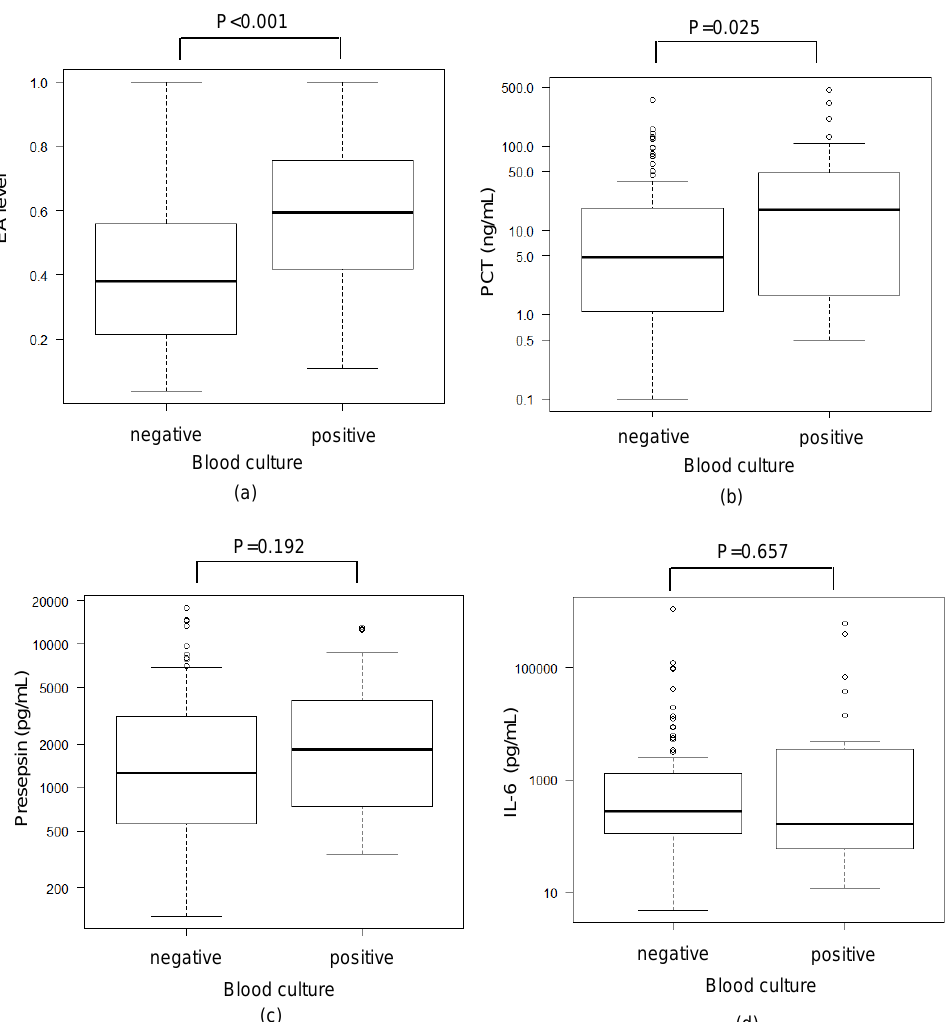
Figure 3. Comparison between the blood culture results and various biomarkers. ( a – d ) Comparisons between the EA level ( a ), PCT level ( b ), presepsin level ( c ), or IL-6 level ( d ) in the blood culture-negative and blood culture-positive groups. The data were analyzed by a Mann–Whitney U test. Significant di ff erences (( a ) p < 0.001, ( b ) p = 0.025) in EA level and PCT were observed between